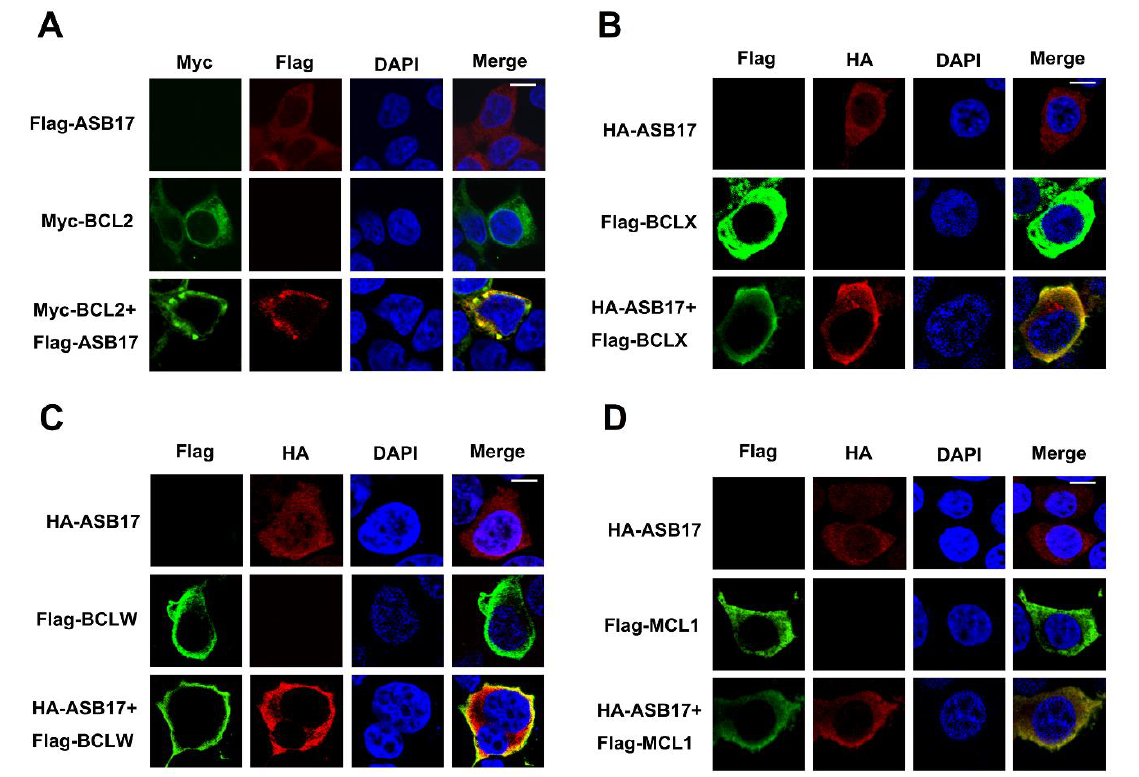
Figure 7. ASB17 interacts with BCL2, BCLX, BCLW, and MCL-1. ( A ) HEK293T cells were co-transfected with Flag-ASB17 and control plasmids, Myc-BCL2 and control plasmids, or Flag-ASB17 and Myc-BCL2 plasmids, respectively. Subcellular localizations of Myc-BCL2 (green), Flag-ASB17 (Red), and nucleus marker DAPI (blue) were analyzed under confocal microscopy. Bar = 10 µ m. ( B ) HEK293T cells were co-transfected with HA-ASB17 and control plasmids, Flag-BCLX and control plasmids, or HA-ASB17 and Flag-BCLX plasmids, respectively. Subcellular localizations of Flag-BCLX (green), HA-ASB17 (Red), and nucleus marker DAPI (blue) were analyzed under confocal microscopy. Bar = 10 µ m. ( C ) HEK293T cells were co-transfected with HA-ASB17 and control plasmids, Flag-BCLW and control plasmids, or HA-ASB17 and Flag-BCLW plasmids, respectively. Subcellular localizations of Flag-BCLW (green), HA-ASB17 (Red), and nucleus marker DAPI (blue) were analyzed under confocal microscopy. Bar = 10 µ m. ( D ) HEK293T cells were co-transfected with HA-ASB17 and control plasmids, Flag-MCL1 and control plasmids, or HA-ASB17 and Flag-MCL1 plasmids, respectively. Subcellular localizations of Flag-MCL1 (green), HA-ASB17 (Red), and nucleus marker DAPI (blue) were analyzed under confocal microscopy. Bar = 10 µ m.